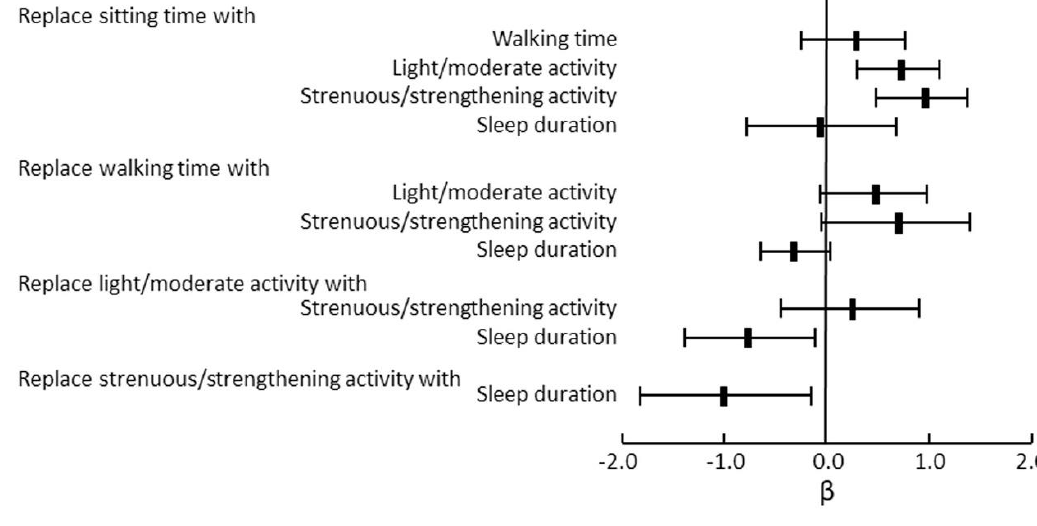
Figure 5. Isotemporal substitution models for FEV1 % predicted in response to 30 min per day substitution of movement behaviors in adults with obstructive lung disease. Replacing 30 min of sitting time with 30 min of light / moderate activity or strenuous / strengthening activity leads to significant improvements in FEV1 % predicted. Adopted from reference 104.